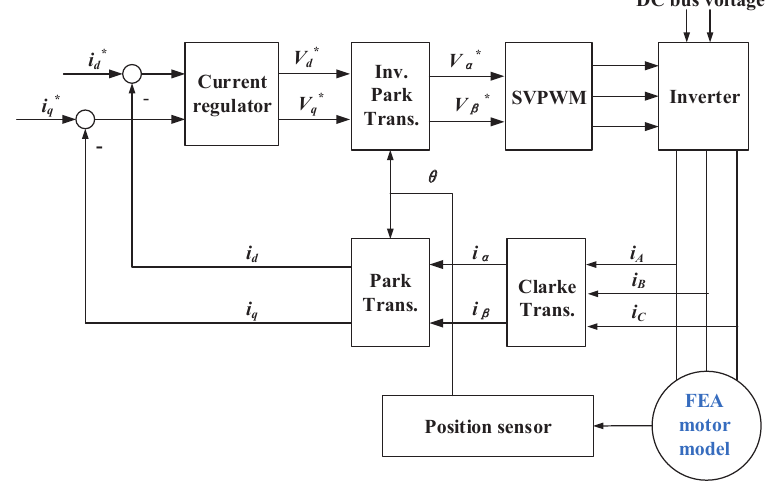
Figure 3. The configuration of Model